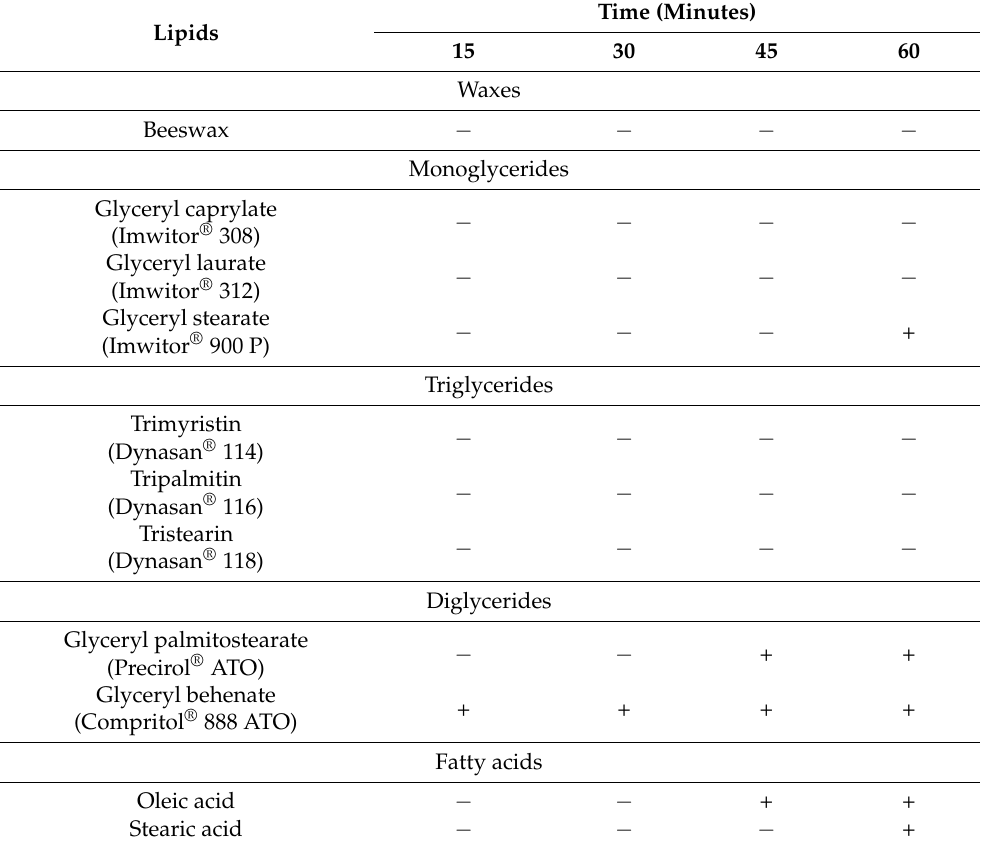
Table 1. Solubility of Alprazolam in various